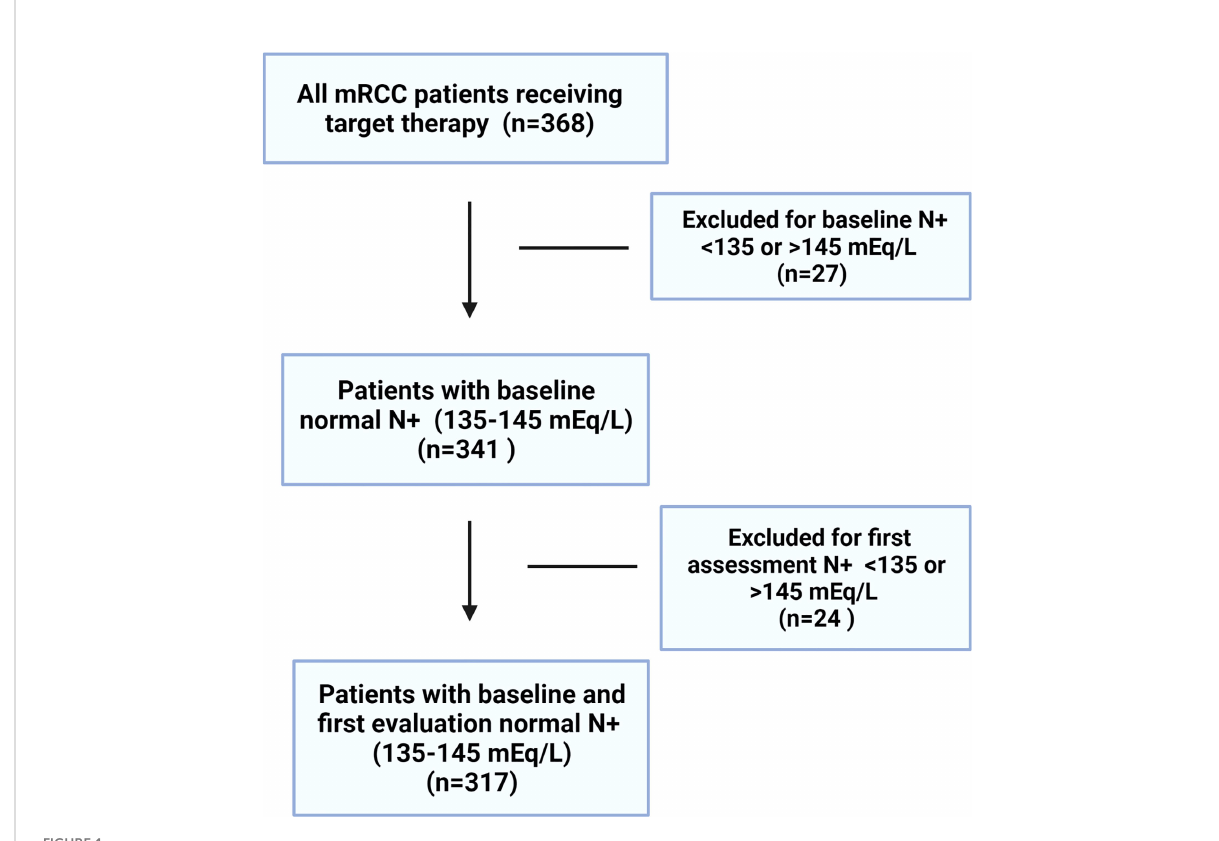
FIGURE 1 The study fl